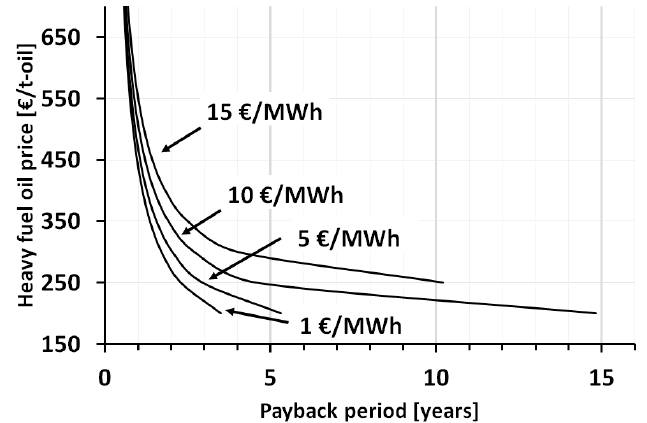
Figure 7. The payback periods when the heat prices of 1, 5, 10, and 15 €/MWh are used. The inlet air temperature of the drying air is 80 °C. All other initial values are shown in Table 5.